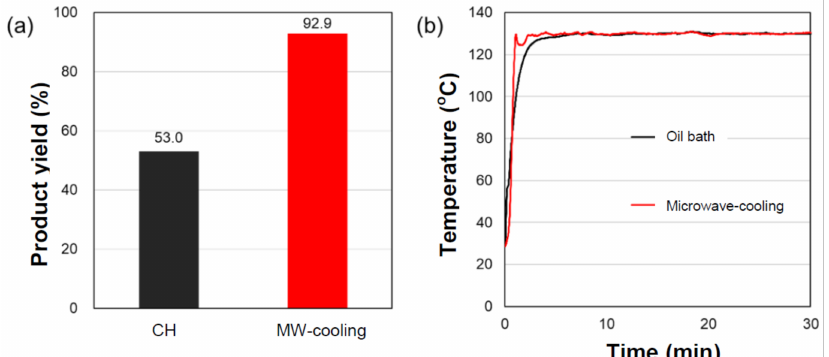
Figure 4. ( a ) Product yields and ( b ) internal temperature profiles in the synthesis of the butanoate ester using oil-bath heating (CH) and microwave heating with air cooling (MW-cooling) in the presence of the heterogeneous AC-SO 3 H catalytic particles. The moisture content in the predistilled butanoic acid batch was